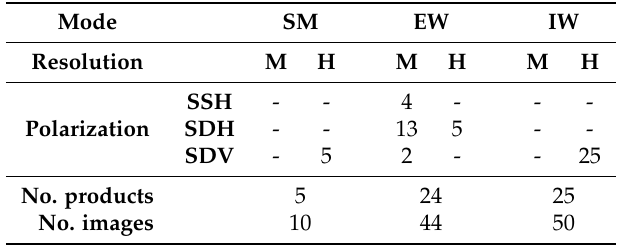
Table 2. Dataset details.